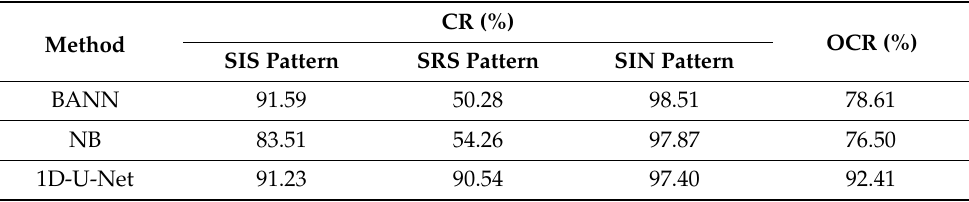
Table 3. Consistence ratios (CRs) and overall CRs (OCRs) of the segmentation results for the test boundaries using different methods.